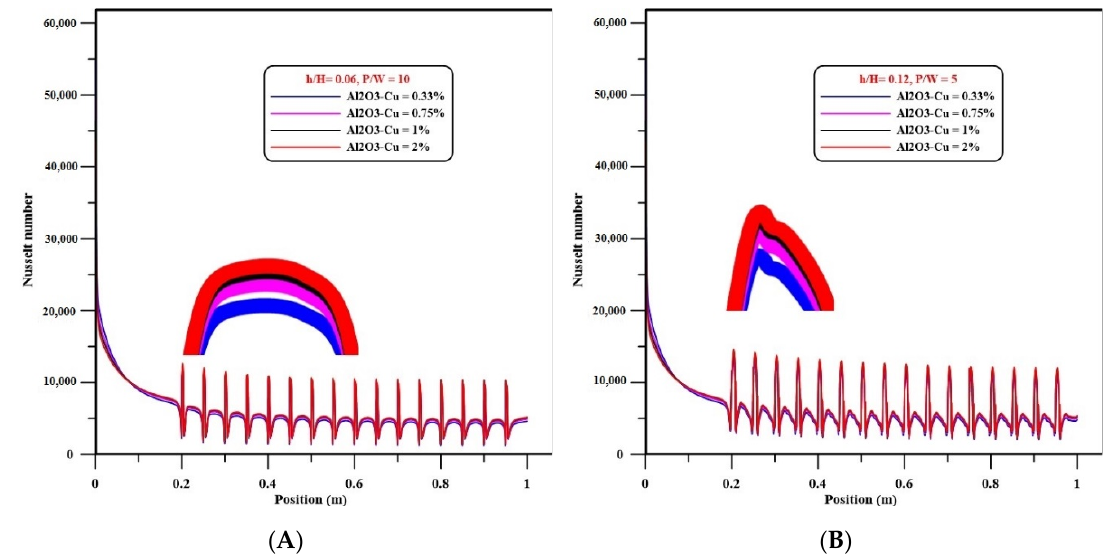
Figure 4. ( A ) Variations of Nusselt number with different hybrid nanofluids of Al 2 O 3 -CuO at h/H = 0.06 and P/W = 10. ( B ) Variations of Nusselt number with different hybrid nanofluids of Al 2 O 3 -CuO at h/H = 0.12 and P/W = 5.